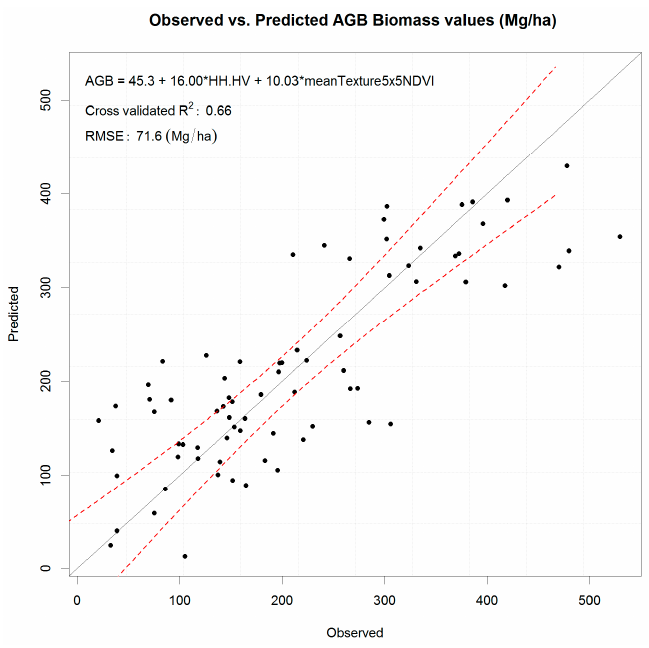
Figure 3. Scatterplot of the observed and predicted AGB values using a multiple linear regression model with HH + HV backscattering and 5 × 5 mean NDVI GLCM texture as